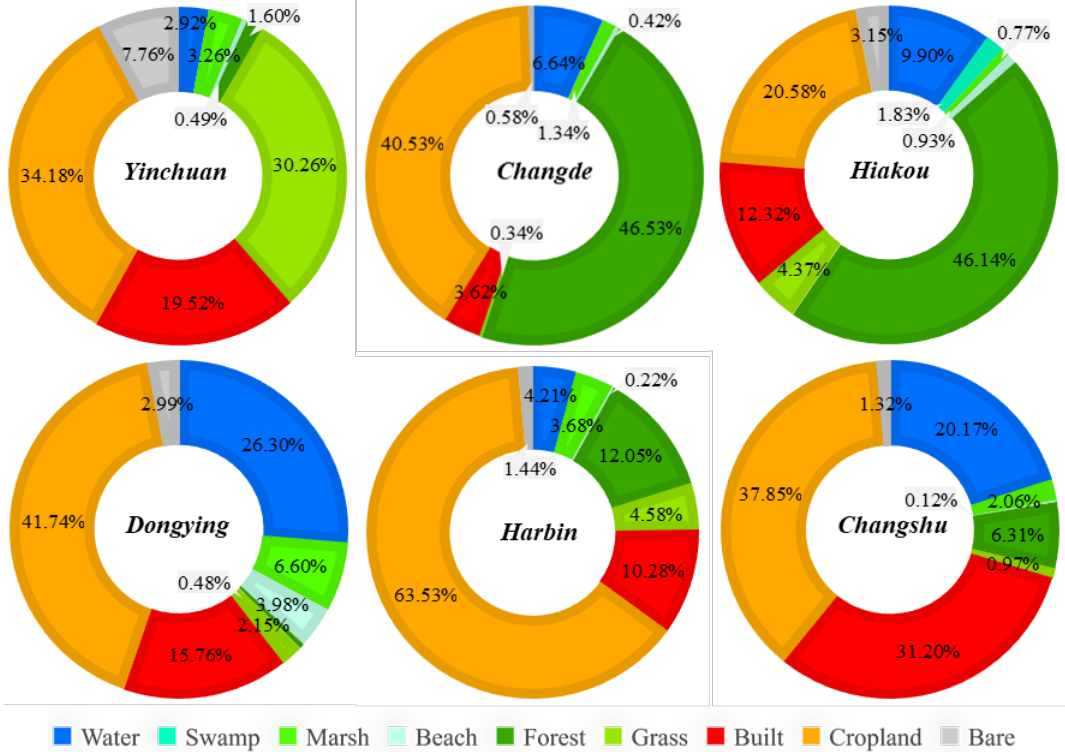
Figure 8. Proportion of land cover within 6 cities during 2015 and 2020 (the inner ring denotes the year of 2015, the outer ring denotes the year of 2020).